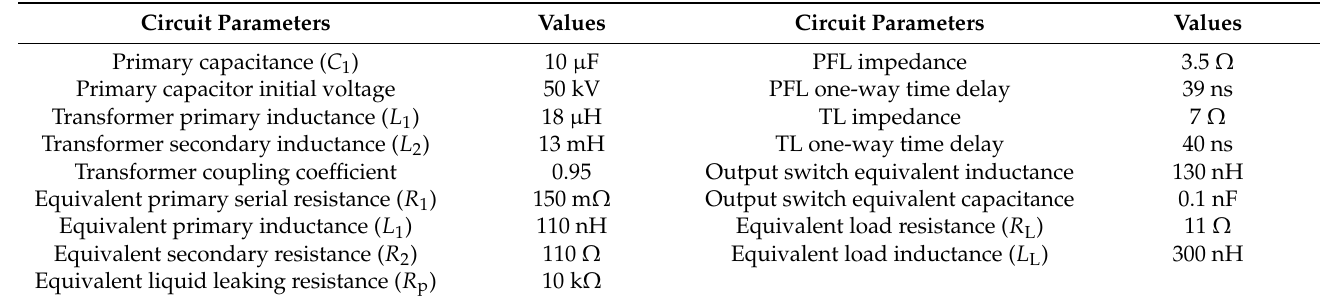
Table 1. Circuit parameters used in